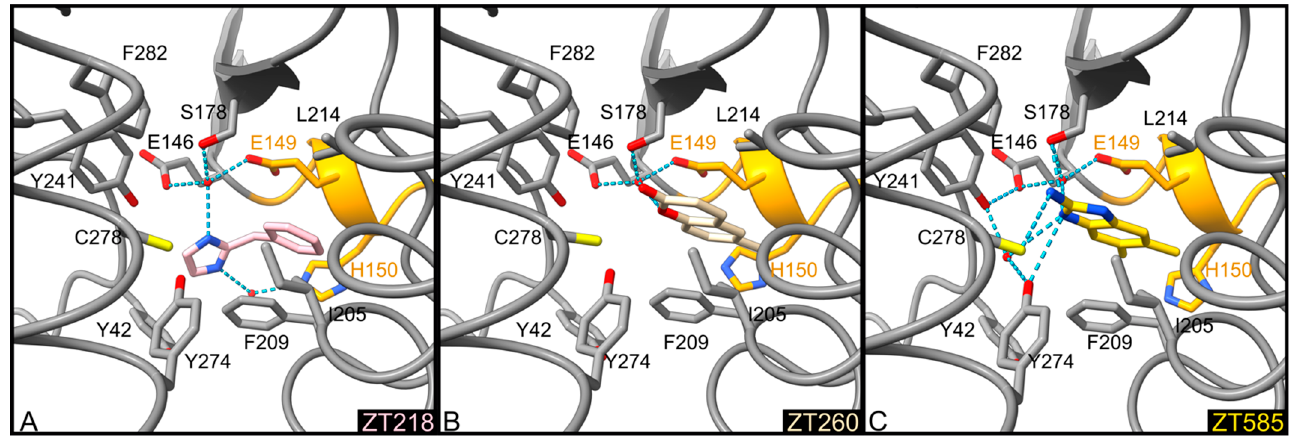
Figure 3. Detailed representation of binding of ZT218 ( A , pink), ZT260 ( B , beige), and ZT585 ( C , yellow) at the substrate binding site. The protein backbone is represented as a tube, the side chains of residues involved in ligand binding are shown as sticks and labelled, water molecules as red spheres, and hydrogen bonds as blue dotted lines. Residues 148–151 forming helix η 1 are coloured orange.